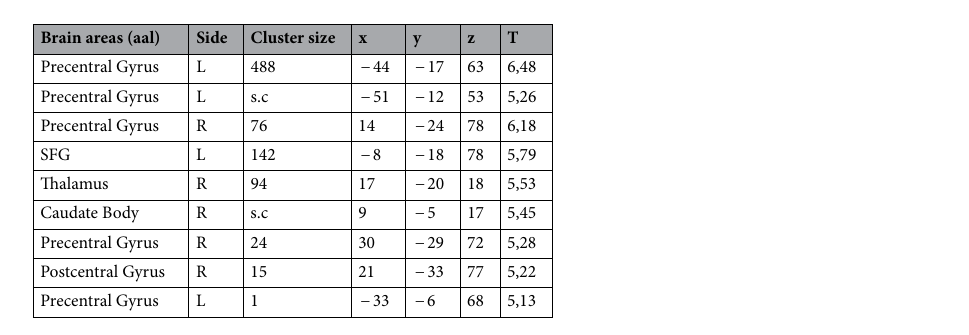
Table 4. Cluster list for contrast heterosexual females > homosexual females (threshold p < 0.05 FWE corrected at voxel level). L/R left/right in the brain; s.c. sub-cluster, SFG Superior Frontal Gyrus.